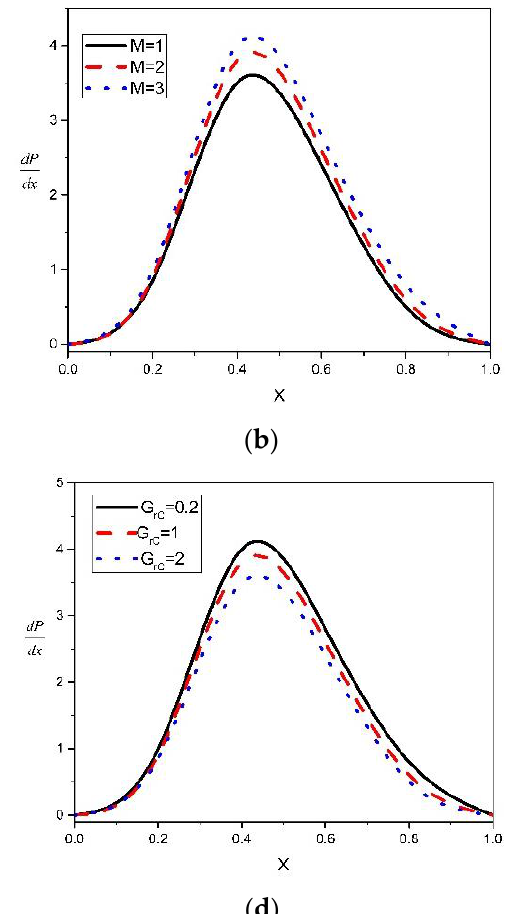
Figure 6. ( a – d ) Pressure gradient versus X for various physical parameters